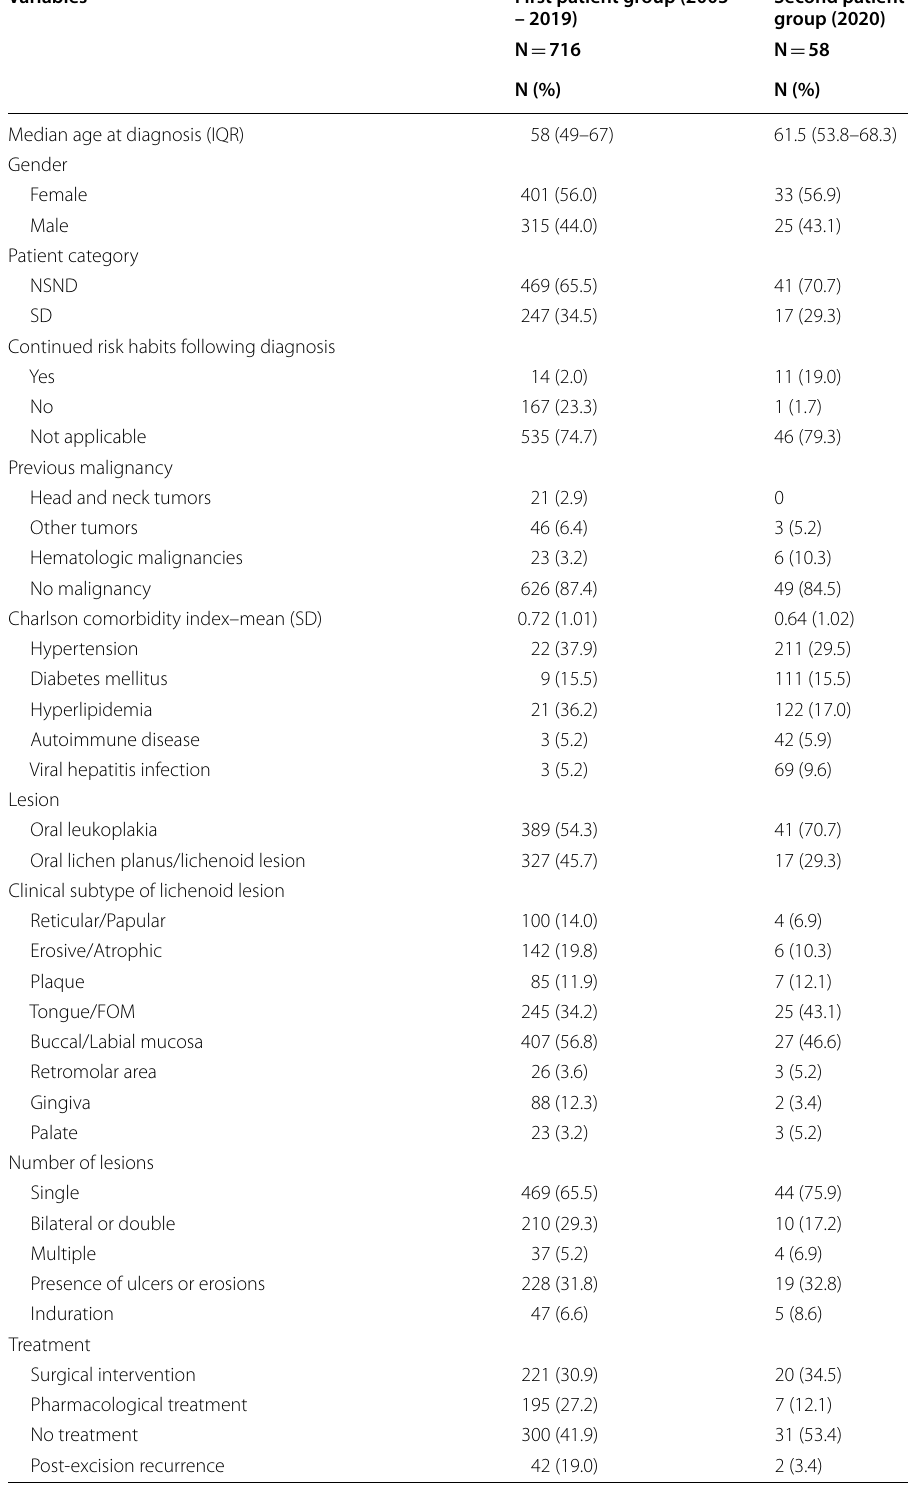
Table 2 Demographic, clinicopathologic, and outcome information of 774 Hong Kong patients used for training and